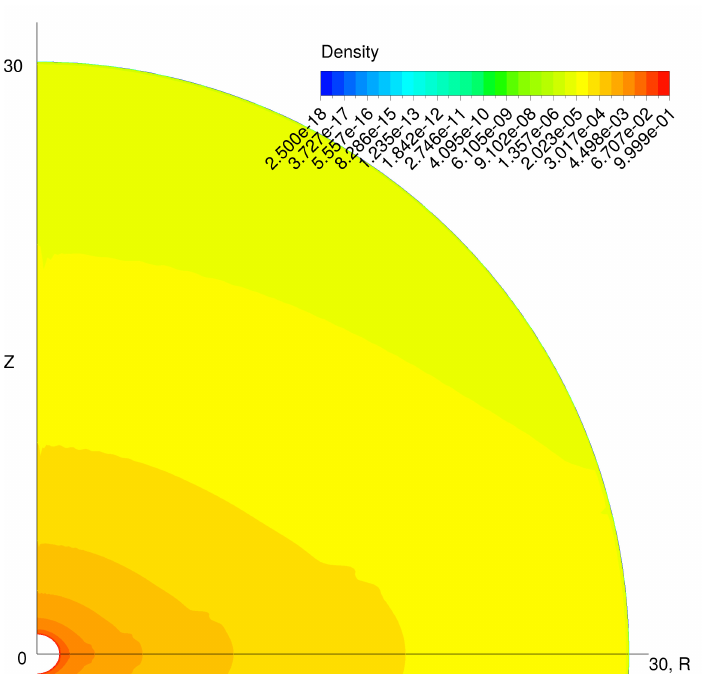
Figure 2. Logarithm of dimensionless density of plasma in the upper hemisphere of the computa- tional domain. All the geometrical values are expressed in units of radius of the star at the pole R pole . T ef f corresponds to the sound velocity v 2 s = 4 × 10 − 3 . ˙ m 0 = 2.4 × 10 − 2 .